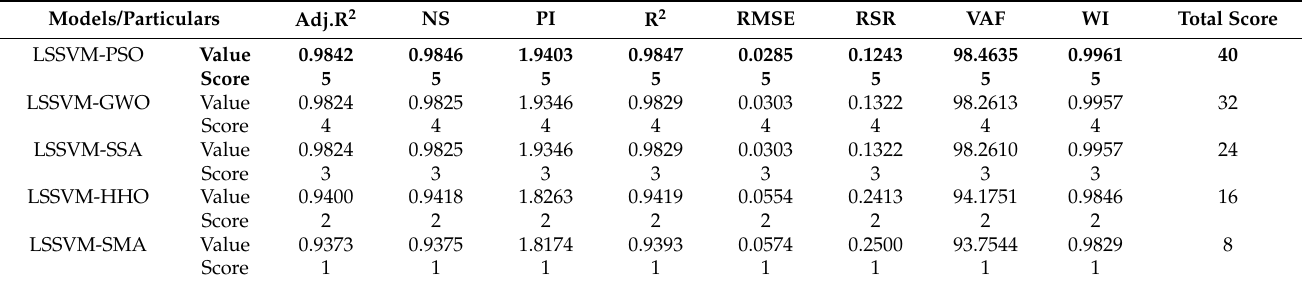
Table 7. Performance parameters for the total